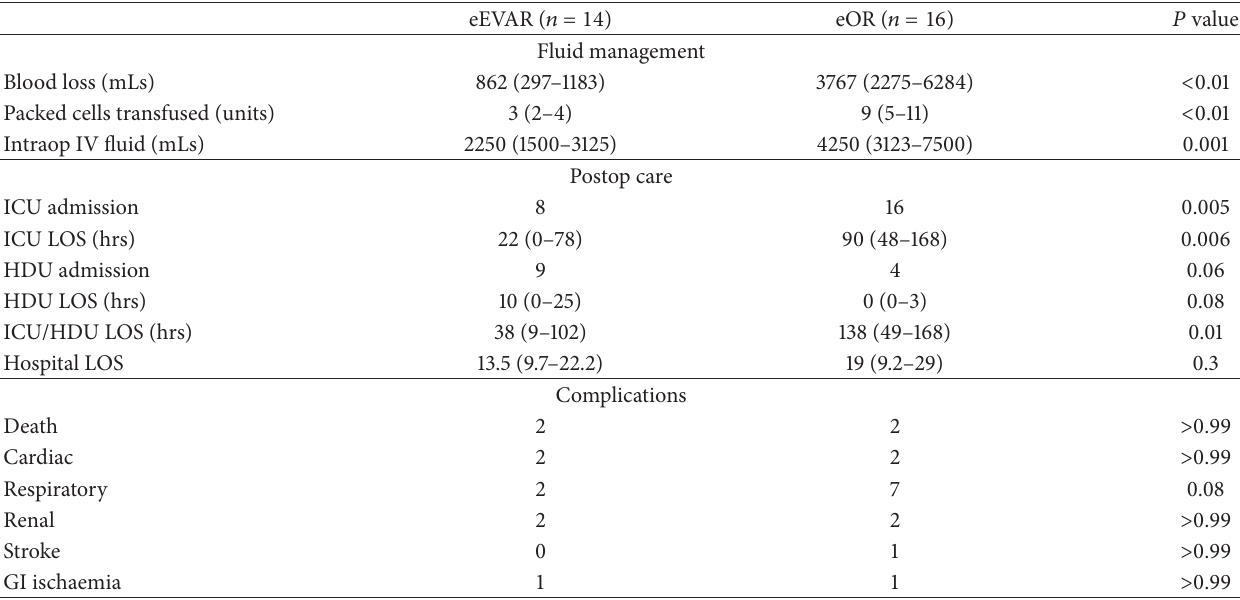
Table 2: Intraoperative and postoperative